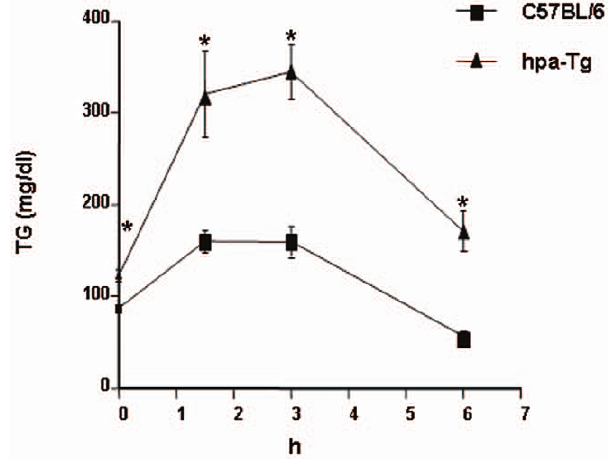
Figure 2. TG accumulation in plasma following oral adminis- tration. Mice were fasted overnight and then administered a bolus of 100 ul corn oil via a stomach tube. TG levels in serum of hpa-Tg mice (n=6) were significantly higher compared to TG levels in C57BL/6 mice (n=6) during the first 3 hrs (p , 0.005 for all measured time points).